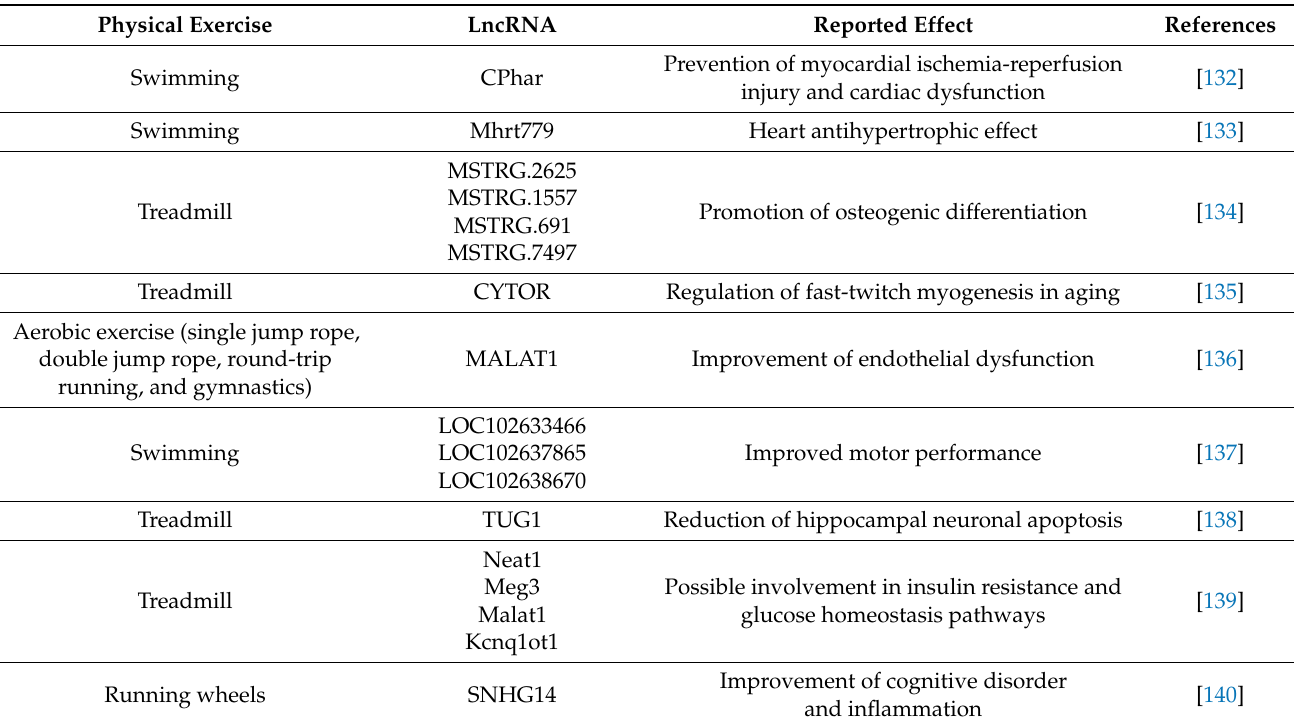
Table 3. Effects of exercise-induced lncRNA